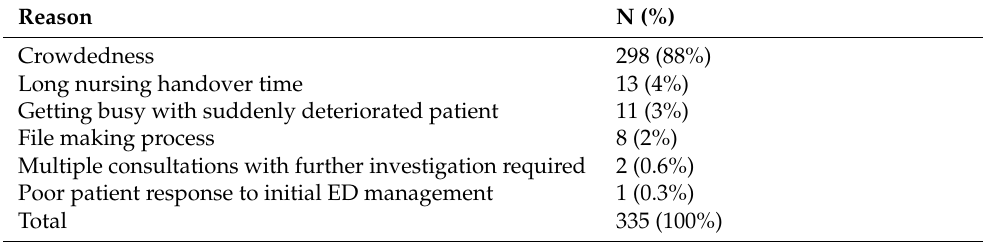
Table 4. Reasons for delay in